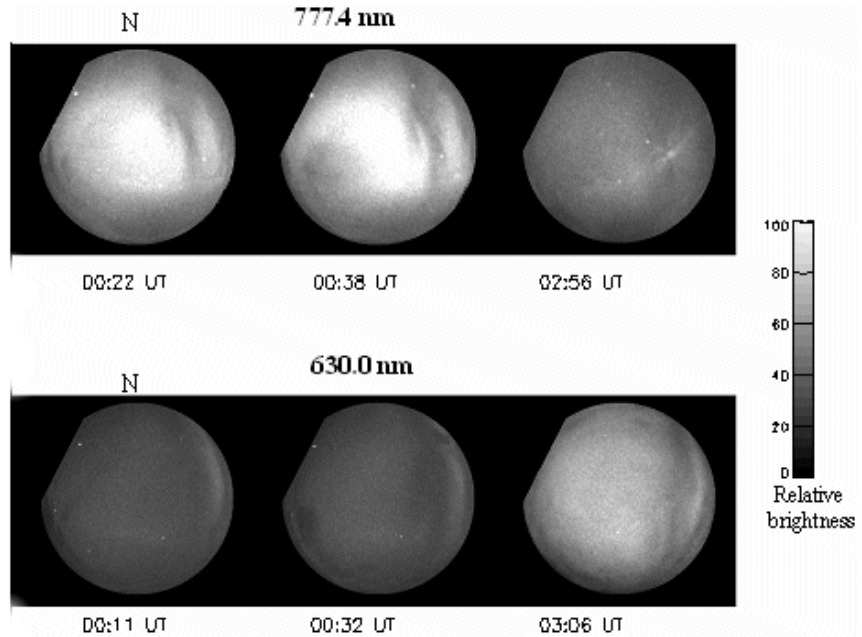
Fig. 8. (Top) High TEC values cause enhancements in 777.4nm airglow images during the 29–30 May 2003 geomagnetic storm, in accor- dance with the results in Fig. 7; (bottom) 630.0nm images.